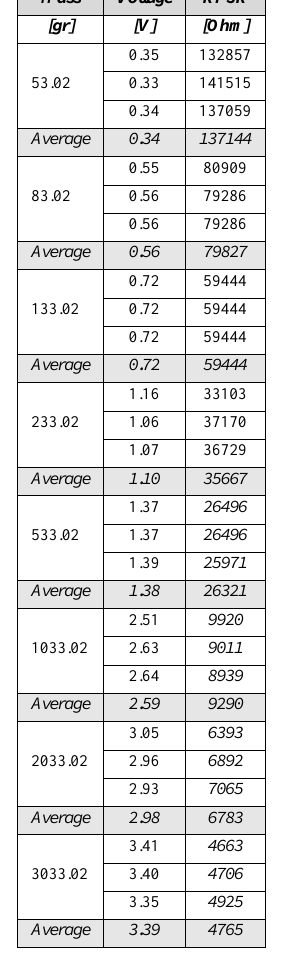
Table 6. Response of the sensor vs. the applied loads on fingertip without the silicone